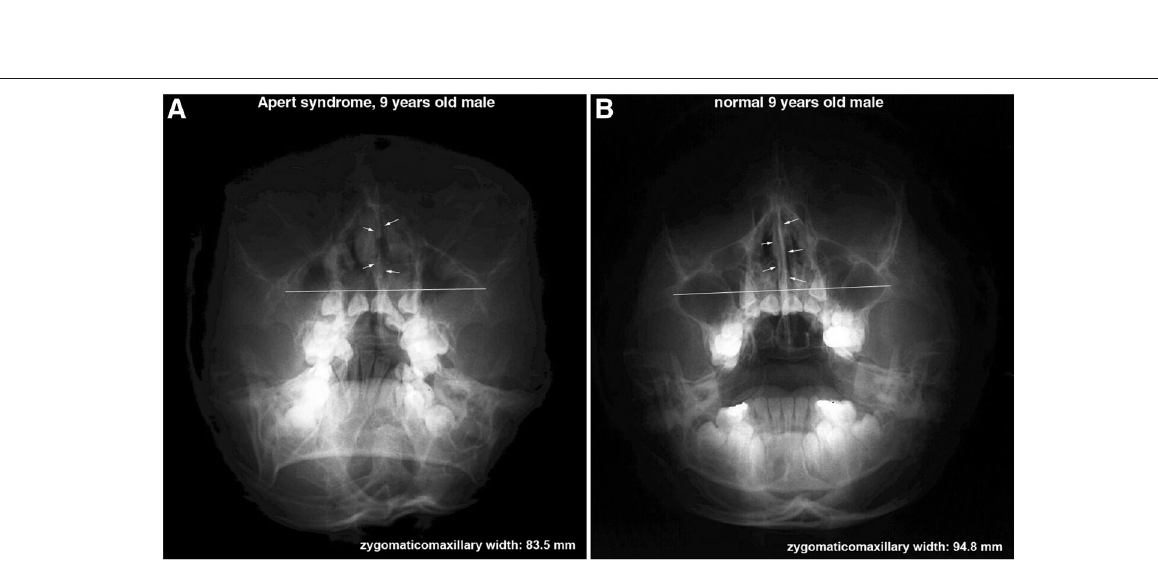
Fig. 3 Water ’ s view: An Apert syndrome patient ( a ), a 9-year-old male, showed a shorter zygomatico-maxillary width and a shorter and thinner nasal septum than a 9-year-old normal male ( b